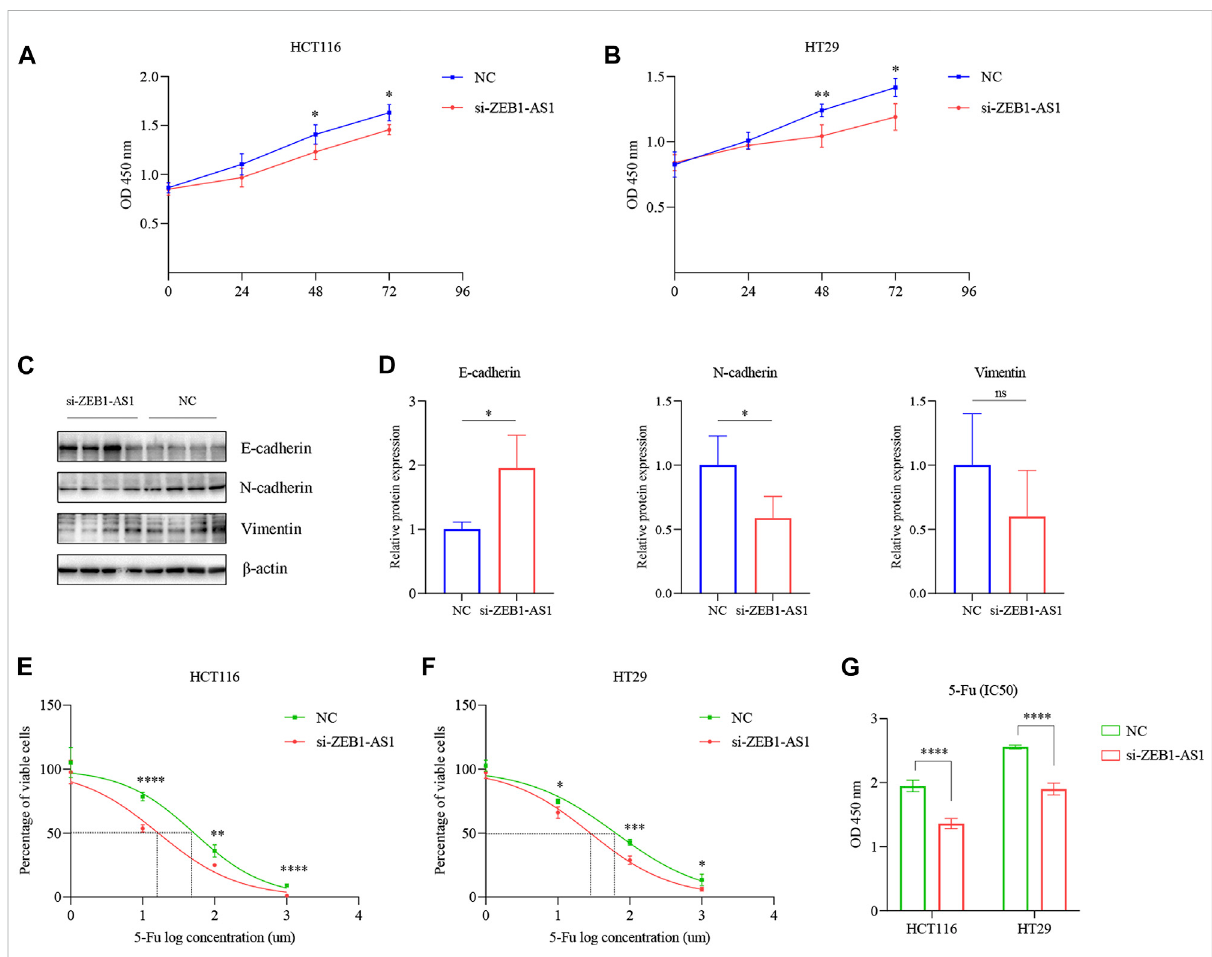
FIGURE 13 ZEB1-AS1 promotes the CRC cell proliferation, metastasis of EMT and chemoresistance to 5-Fu in vitro . (A,B) The proliferative ability of HCT116 and HT29 cells was determined by CCK8 assay. (C,D) Protein levels of E-cadherin, N-cadherin, and Vimentin were measured by Western blot. Data are presented as means ± SD. (E,F) Cells were transfected by ZEB1-AS1 siRNA and then exposed to serial dilutions of 5-Fu for 48 h (cell viability was determined by CCK8 assay and data are presented as the percentage of viable cells). (G) Cells were transfected by ZEB1-AS1 siRNA andthen inthepresenceofIC50 5-Fu for 48 h(cellviability wasdeterminedbyCCK8assay anddata arepresentedas thepercentage ofviablecells). * p < 0.05; ** p < 0.01; *** p < 0.001; **** p <